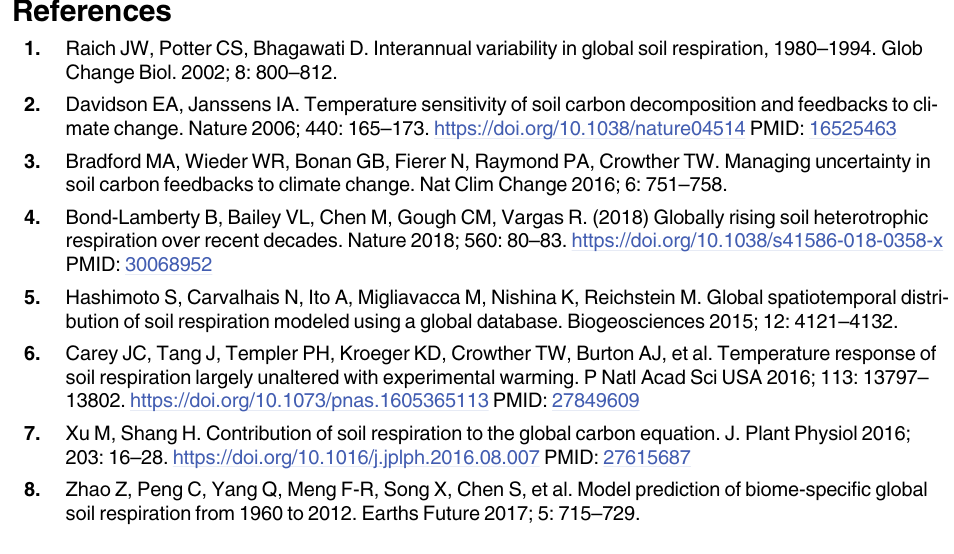
S2 Table. Likelihood Ratio tests of differences between models, where Model 1 is nested within Model 2. The chi-squared and p -values refer to one-sided tests of the null hypothesis that the log-likelihood of Model 2 is not different from that of Model